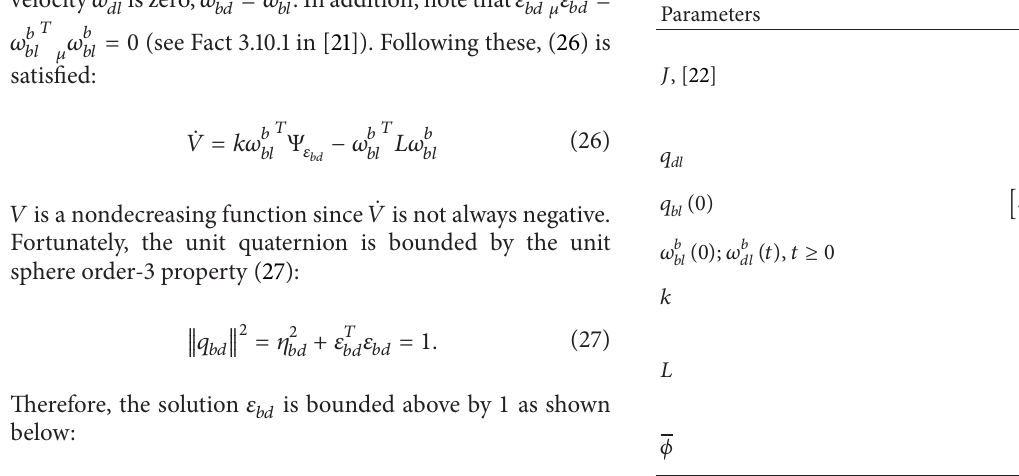
Table 1: Parameter simulation for single spacecraft